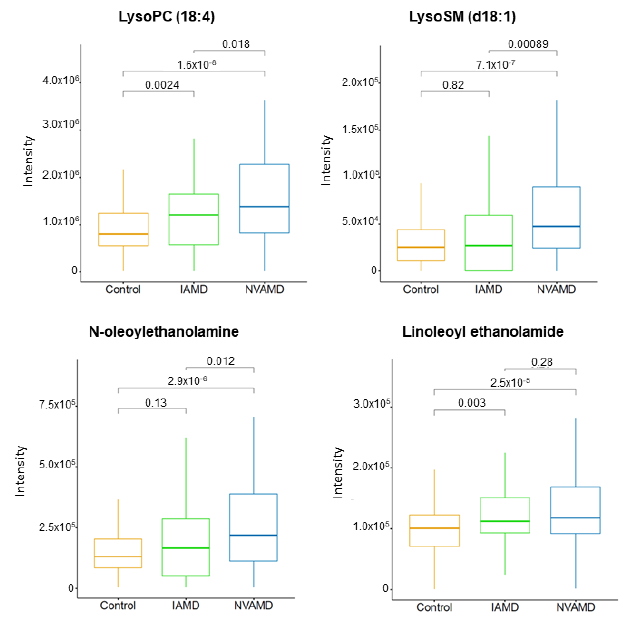
Figure 4. Plasma steroid-related metabolites altered in AMD patients. Plasma levels of the steroid- related metabolites cortexolone and 25-hydroxyvitamin D2 were altered in AMD patients. Kruskal– Wallis tests were used for pairwise comparisons and p -values are shown above comparison brackets. The molecular identities of these metabolites have been confirmed at MSI level